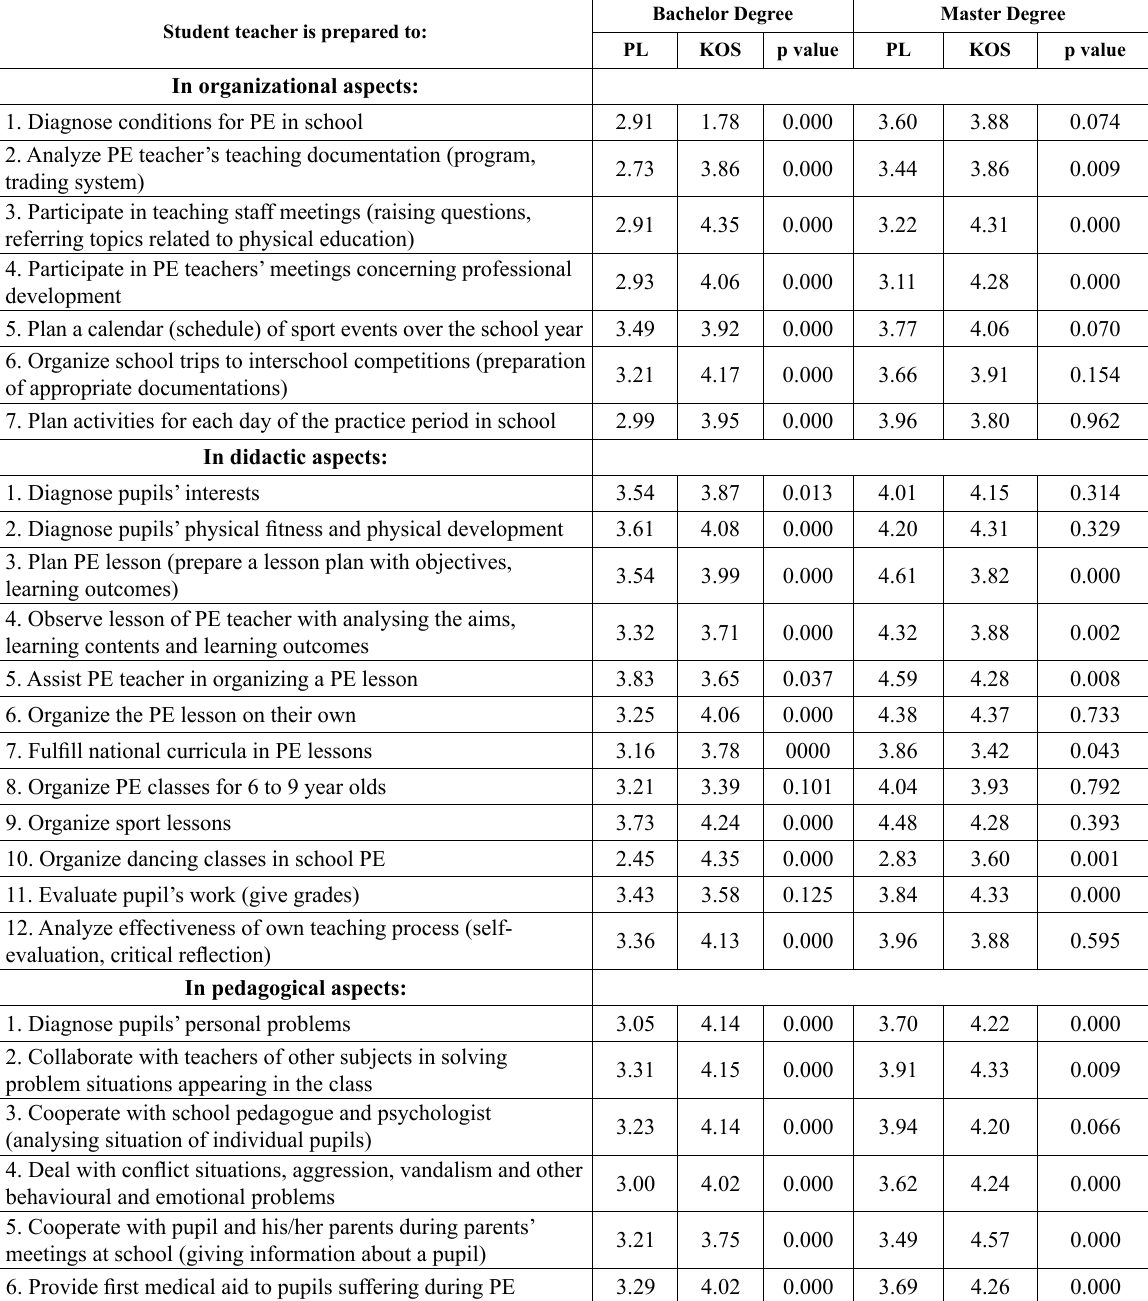
Table 2. Mean scores of Physical Education students from Poland and Kosovo in specific aspects of their preparation for teaching practice Student teacher is prepared